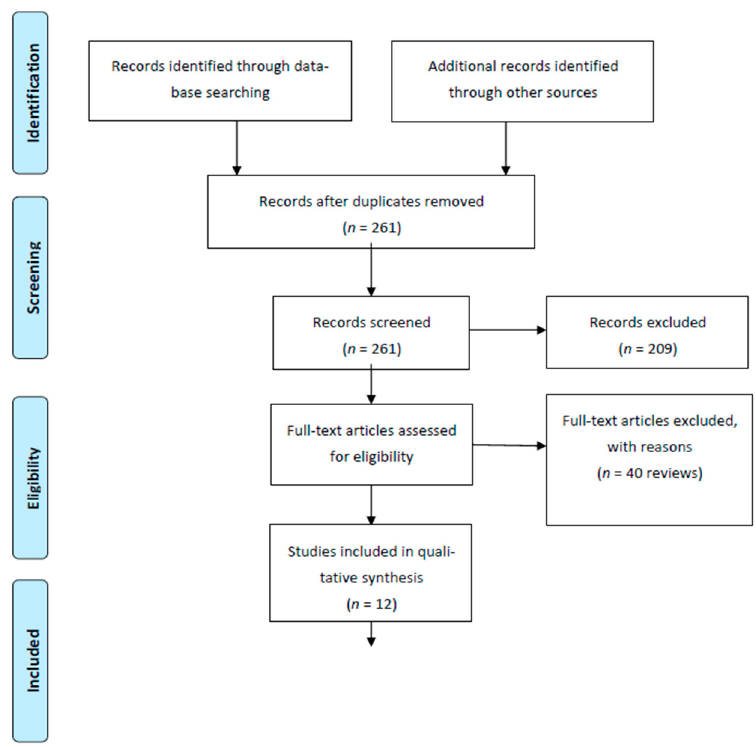
Figure 1. Flow Figure 1. Flow diagram.